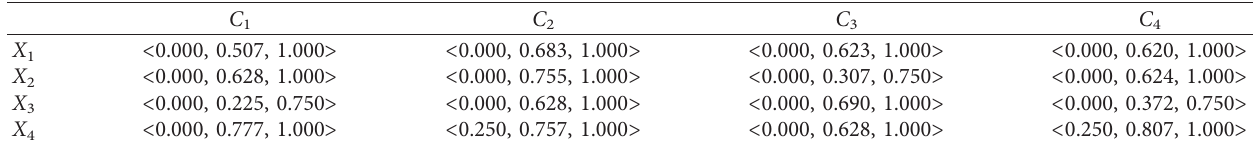
Table 7: TFN decision matrix H